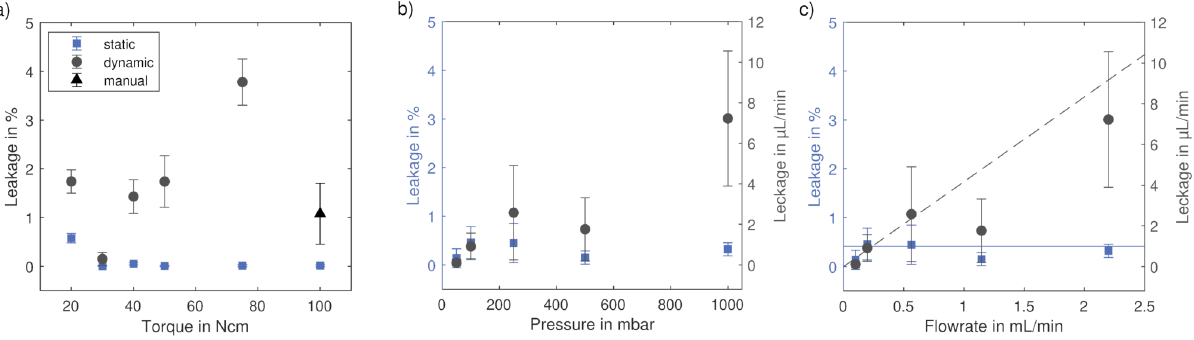
Figure 6. Influence of axial compression and pressure on leakage; ( a ) leakage stream of upscaled valve in % in dependence of torque required to rotate valve. Experiments were performed at a pressure of 500mbar in triplicates; ( b ) influence of applied pressure on leakage stream of upscaled valve. Experiments were run at a torque of 30Ncm and performed in triplicates; ( c ) results from ( b ) shown in dependence of flow rate instead of pressure. Blue line shows maximum relative dynamic leakage, and dashed gray line maximum absolute dynamic leakage under experimental